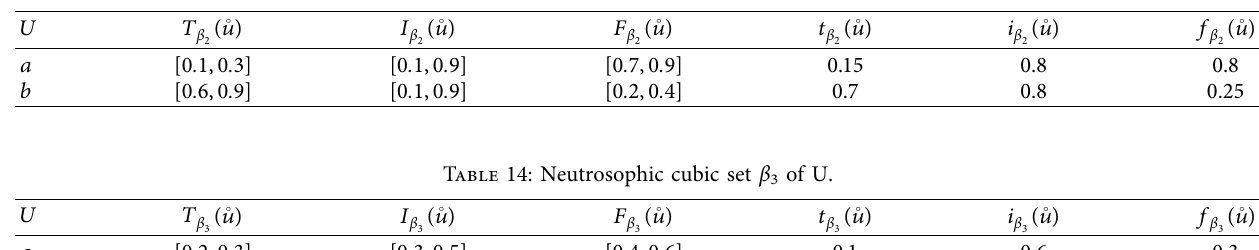
Table 13: Neutrosophic cubic set β